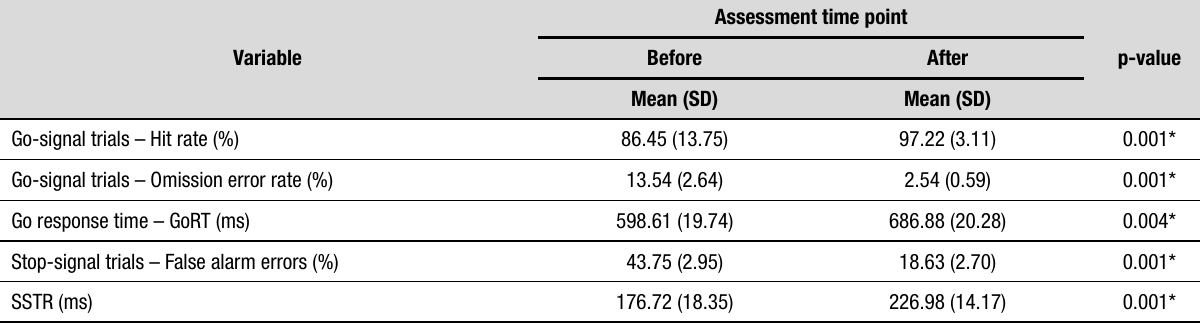
Table 2. Inhibitory control performance before and after training.